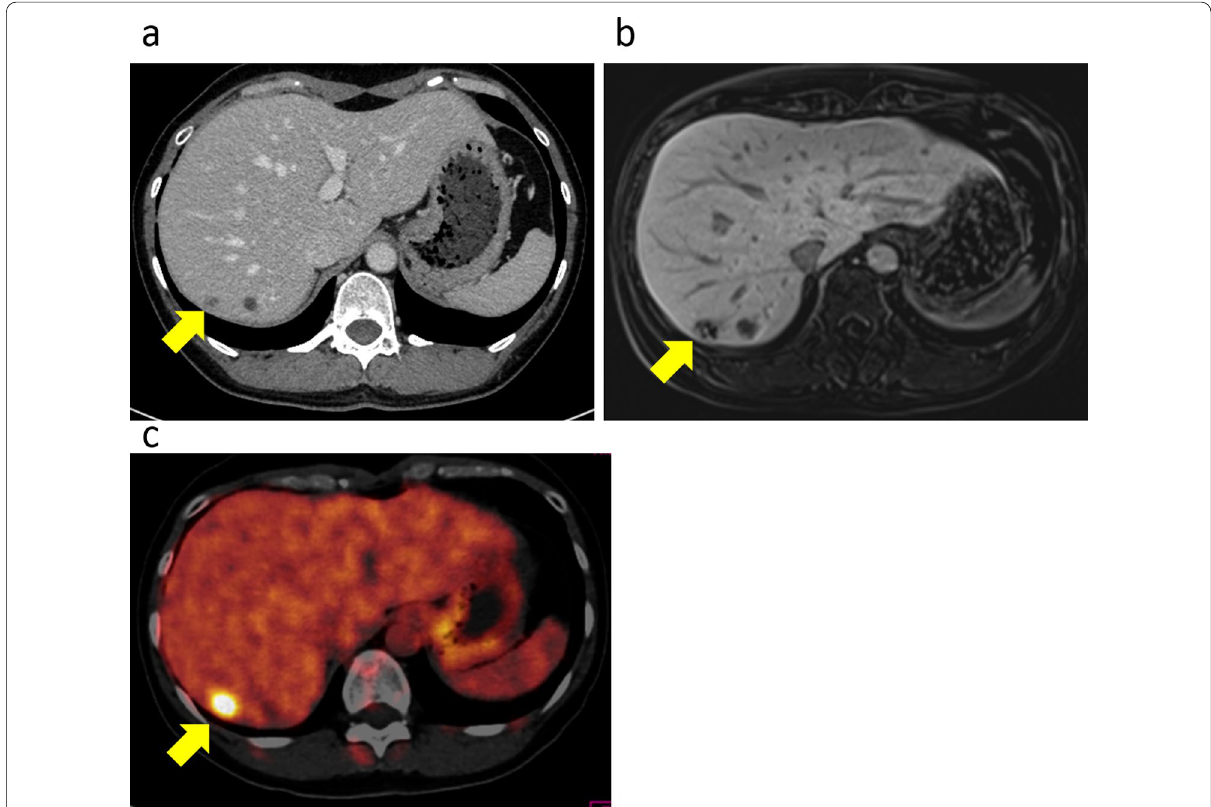
Fig. 3 Imaging findings of the liver metastasis. a CT demonstrated a 14-mm-sized tumor with a faint contrast effect on the margin of liver S7. b The tumor showed a low signal intensity in the hepatocellular phase of Gd-EOB-DTPA-enhanced MRI. c The tumor showed strong accumulation of FDG on